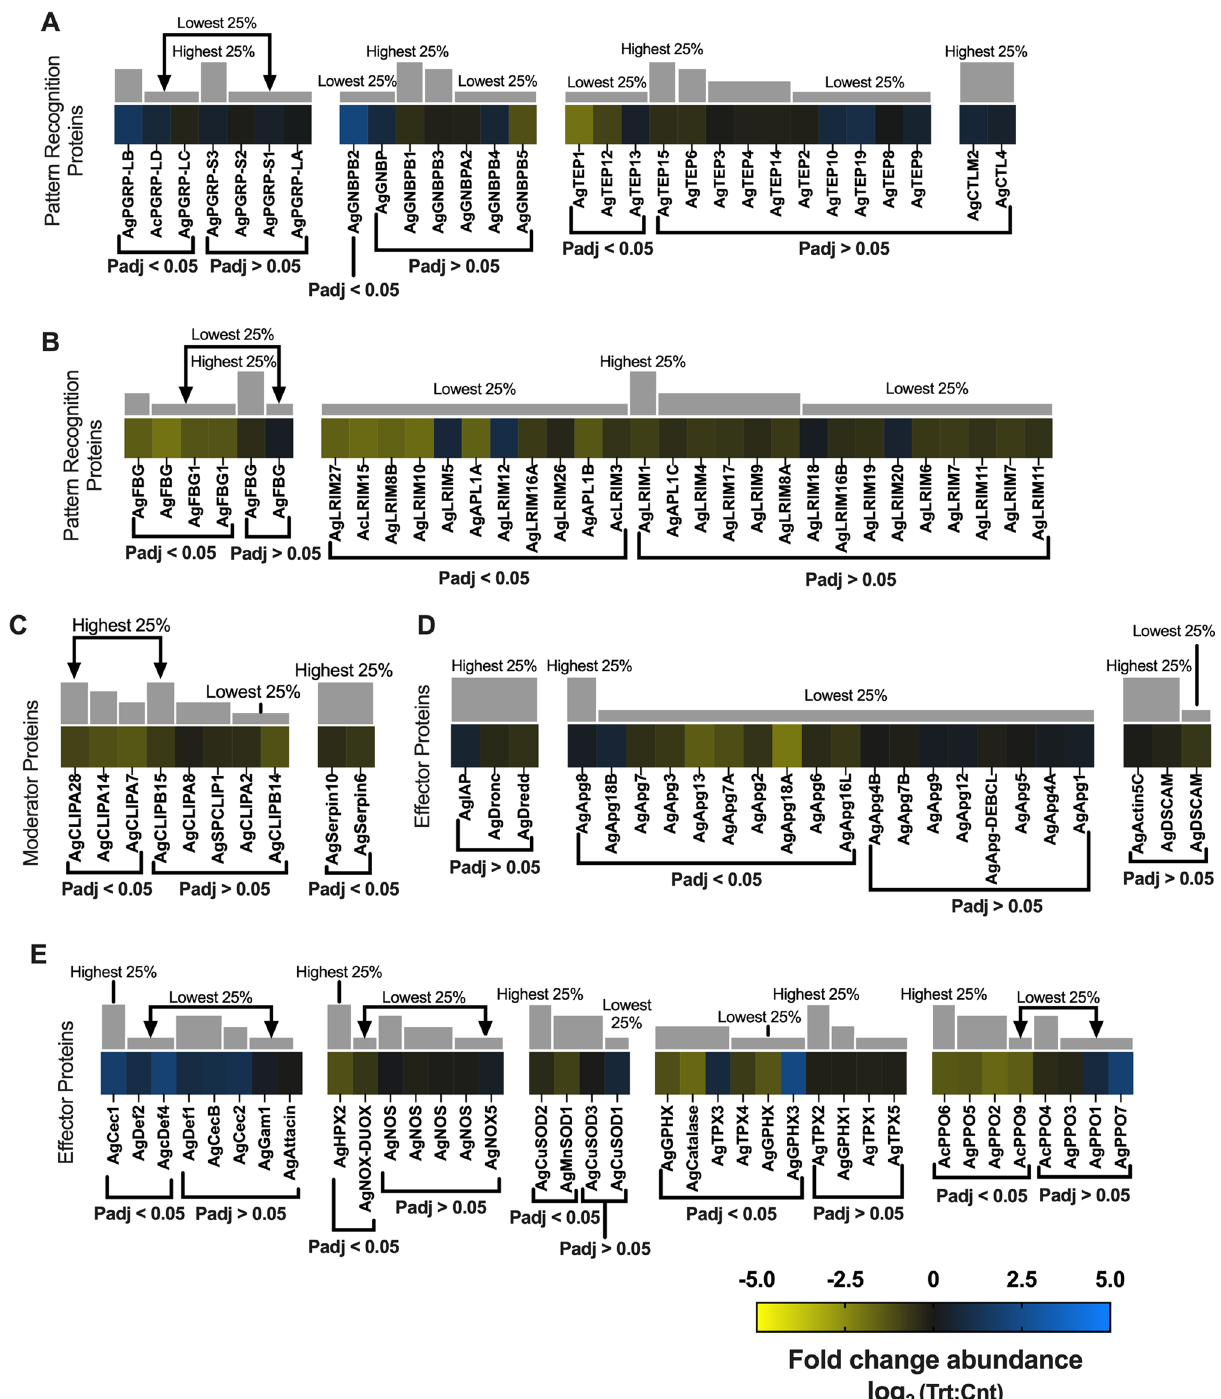
Figure 10. Immune response differential transcript abundances following relevant sporozoite infections. Immune response transcripts that were present at significantly higher (blue) or lower (yellow) levels in Plasmodium falciparum sporozoite infected treatments; non-differentially expressed immune response transcripts are denoted as zeros (black). Immune response genes within each group organized by adjusted p-value and subsequently arrayed left to right from most abundant to least abundant based on FPKM values (quartile bars above each image). ( A, B ) Pattern recognition proteins. ( C ) Modulator proteins. ( D, E ) Effector proteins. Log 2 scale indicates transcript abundances that were significantly higher (blue) or lower (yellow) in sporozoite infected treatments (Trt) vs. naïve controls